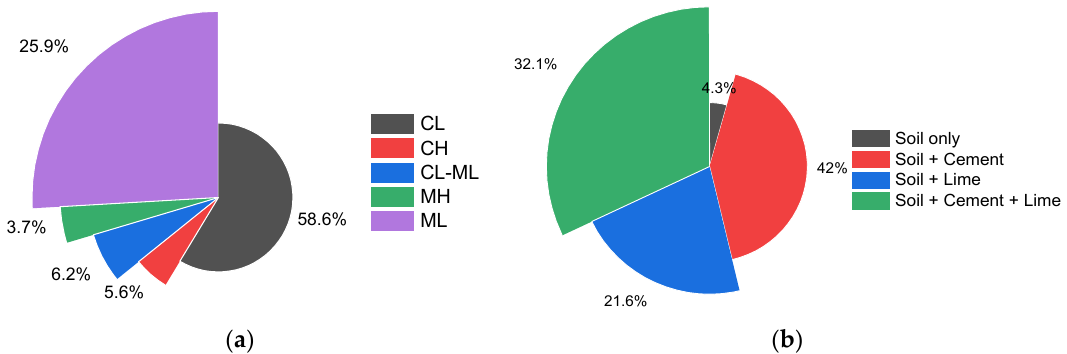
Figure 6. The proportion of soil types and stabilizers in the dataset. ( a ) soil types, ( b ) soil plus stabilizers.